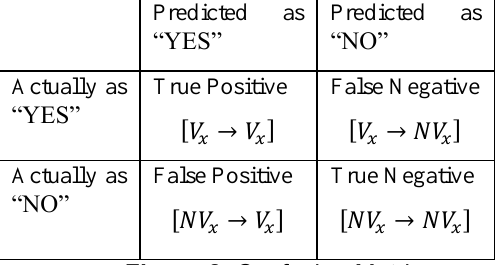
Figure 8. Confusion